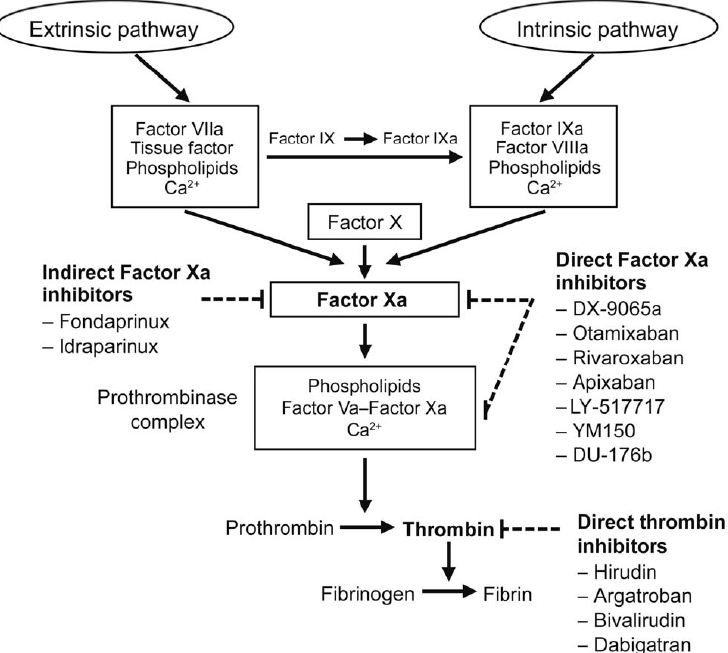
Figure 5. Targets for anticoagulant drugs in the coagulation pathway from the Burghaus model [4].